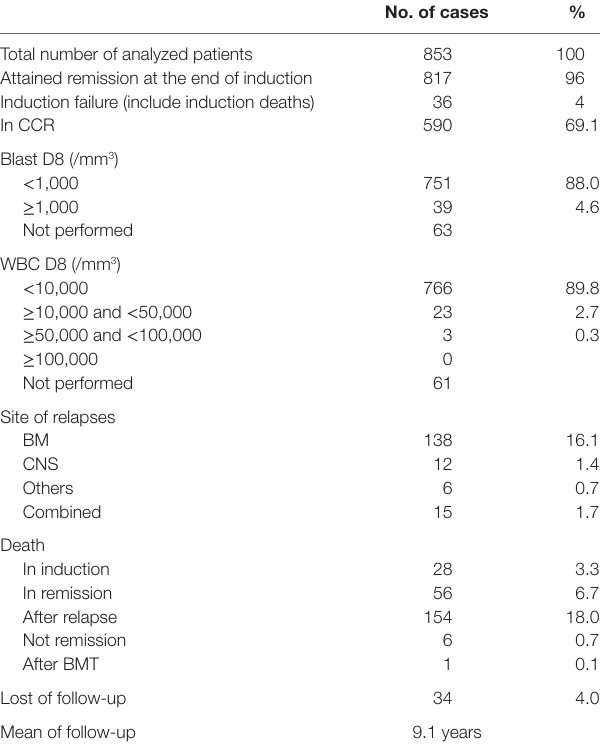
TaBle 3 | clinical and laboratorial data of 853 patients with all treated with gBTli all-93